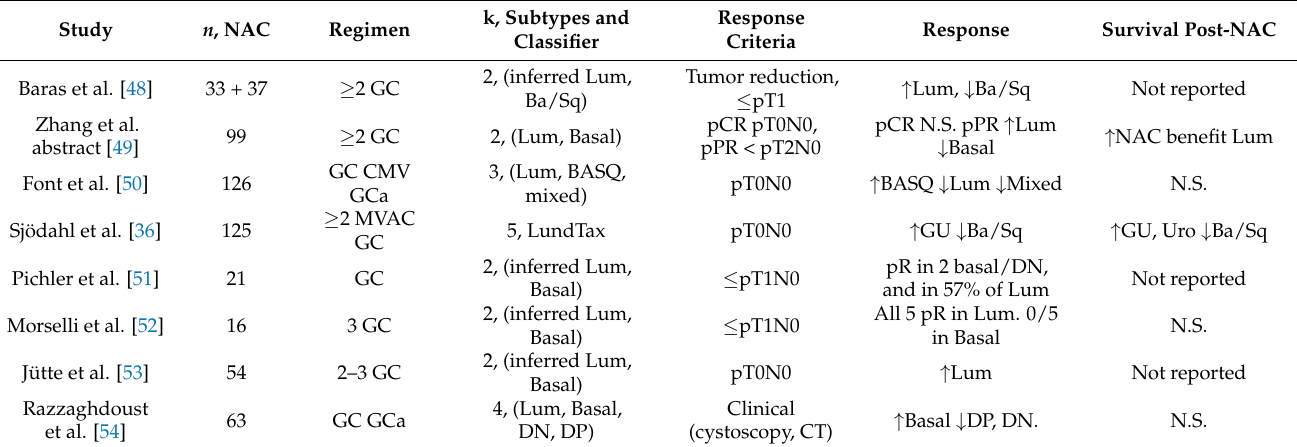
Table 2. Studies on NAC response with IHC- or RNA-panel